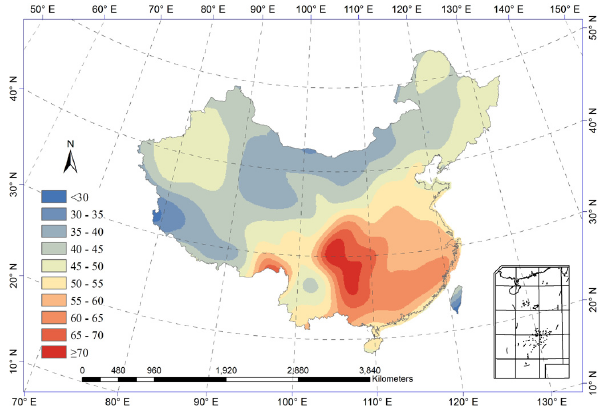
Fig. 8. Spatial distribution of perennial average of annual diffuse fraction in China during 1981–2010 (Unit: %).